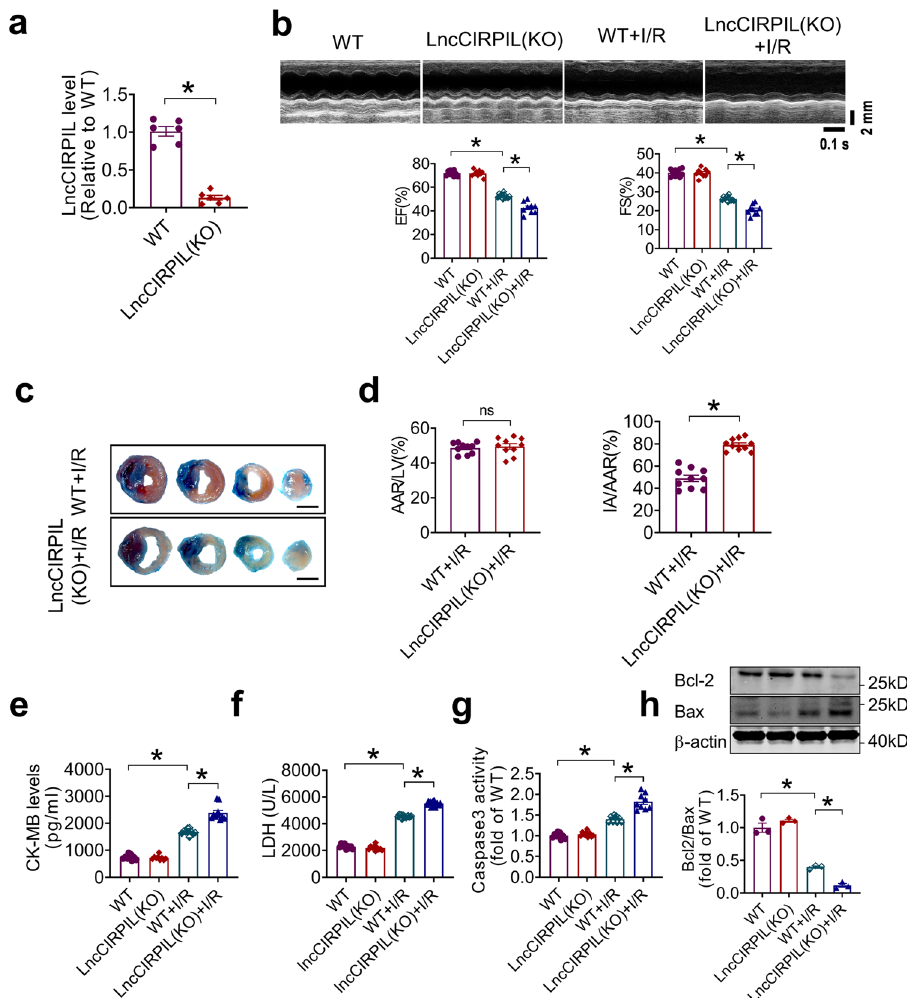
Fig. 4 Knockout of lncCIRPIL exacerbates cardiac ischemia/reperfusion (I/R) injury in mice. a The expression of LncCIRPIL in heart tissue of WT and lncCIRPIL-KO mice. n = 6. * P < 0.05 vs WT by two-tailed Student ’ s t test. b Representative cardiac echocardiography and statistical analysis of cardiac function of WT and lncCIRPIL-KO mice subjected to cardiac I/R injury. EF, eject fraction; FS, fractional shortening. n = 9 to 11. * P < 0.05 by one-way ANOVA followed by Tukey post hoc analysis. c , d Representative images of heart sections from WT and lncCIRPIL-KO mice after I/R injury by TTC and EVANS blue staining, and statistical analysis of at-risk area (AAR) and infarct area (IA) to AAR ratio. n = 10. * P < 0.05 vs WT + I/R by two-tailed Student ’ s t test. Scale bar = 2 mm. e Serum CK-MB in WT and lncCIRPIL-KO mice after cardiac I/R injury. n = 9 or 10. * P < 0.05 by one-way ANOVA followed by Tukey post hoc analysis. f Serum LDH in WT and lncCIRPIL-KO mice after cardiac I/R injury. n = 9 to 16. * P < 0.05 by one-way ANOVA followed by